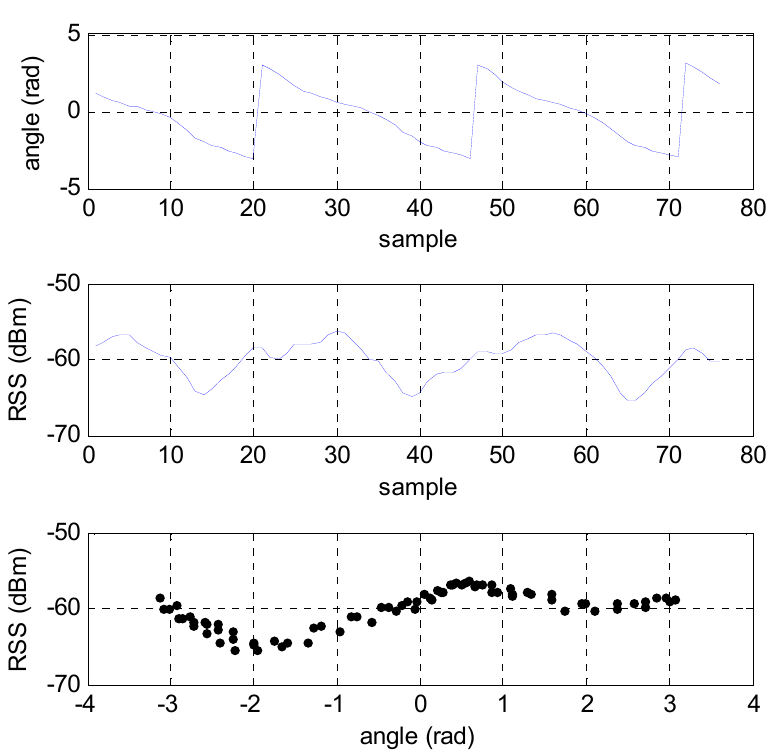
Figure 12. Variation of RSS due to antenna orientation. Top plot is the azimuth angle approximated by the tablet magnetometer and accelerometer output. Middle plot is a segment of the RSS samples collected for the 2.4 GHz AP channel and the bottom plot is the RSS as a function of the azimuth angle.